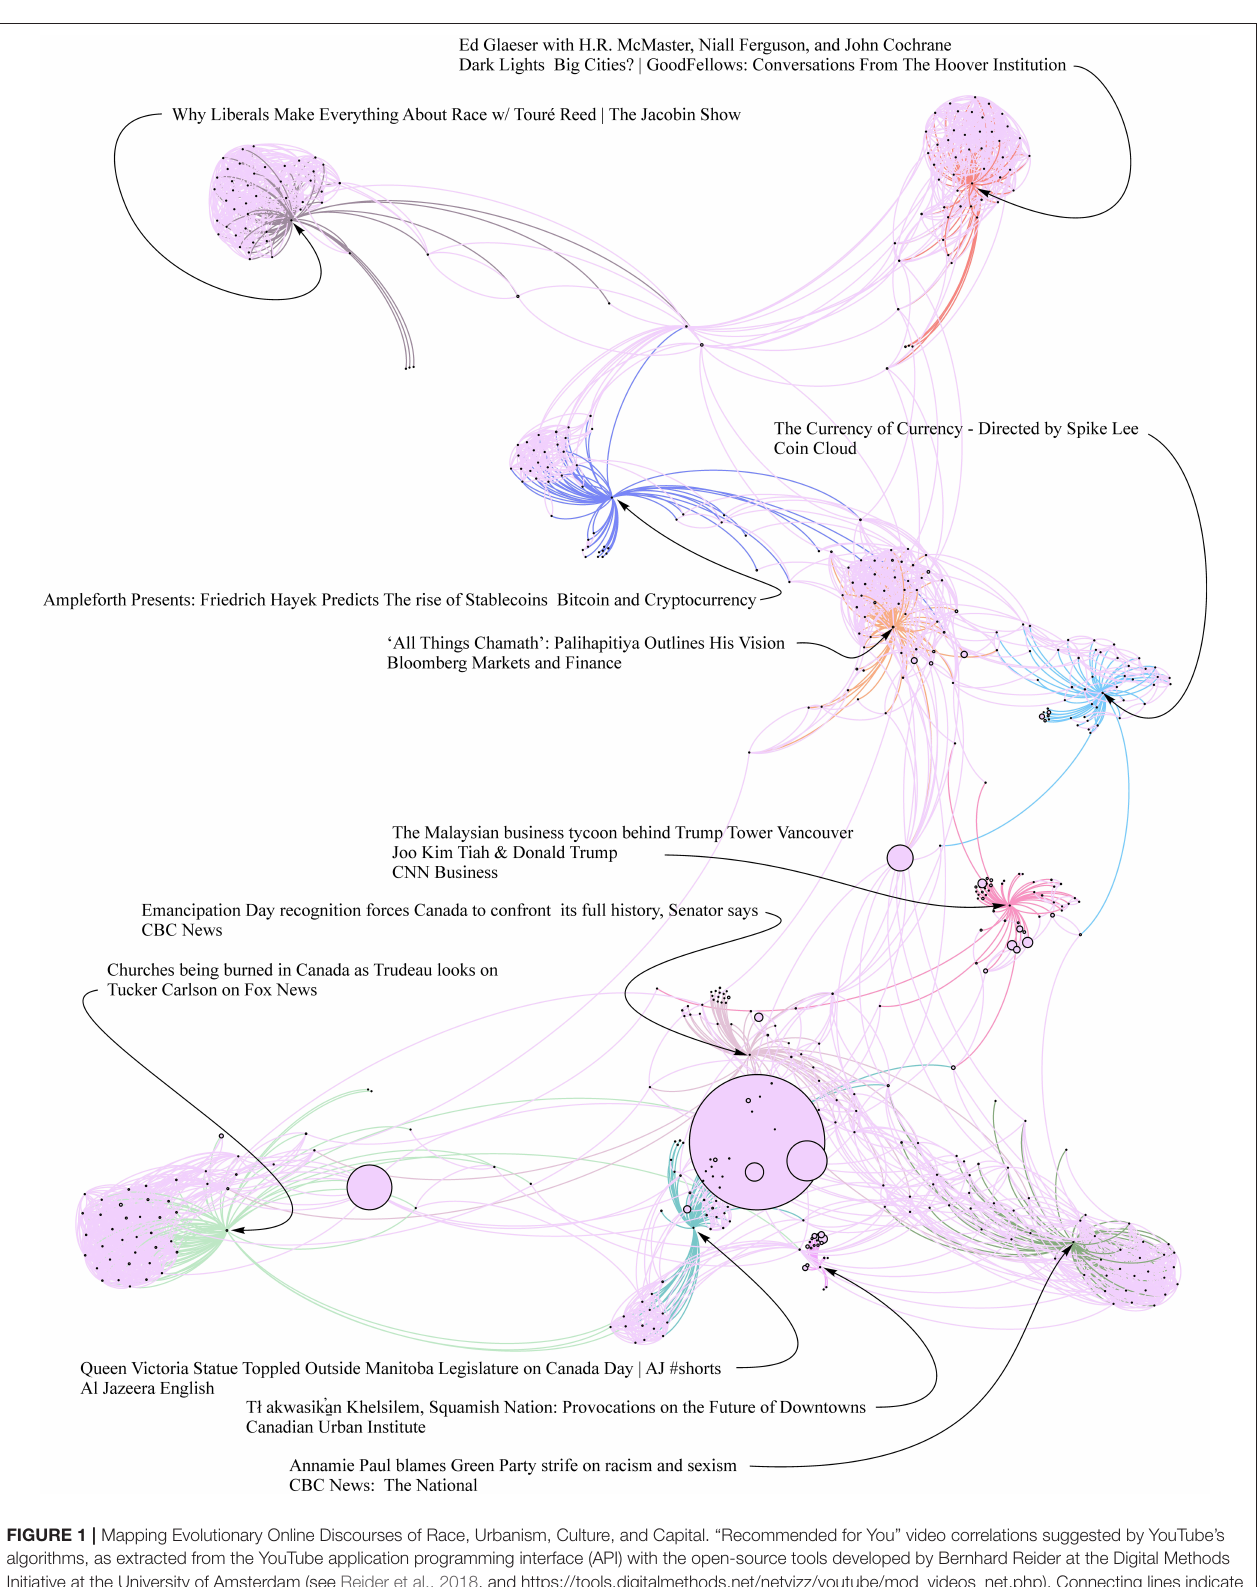
FIGURE 1 | Mapping Evolutionary Online Discourses of Race, Urbanism, Culture, and Capital. “Recommended for You” video correlations suggested by YouTube’s algorithms, as extracted from the YouTube application programming interface (API) with the open-source tools developed by Bernhard Reider at the Digital Methods Initiative at the University of Amsterdam (see Reider et al., 2018, and https://tools.digitalmethods.net/netvizz/youtube/mod_videos_net.php). Connecting lines indicate correlated suggestions by YouTube’s algorithmic analysis of individual and collective viewer preferences. Bubble sizes scaled proportional to viewcount. Data extracted August 3, 2021. Graphic constructed by the